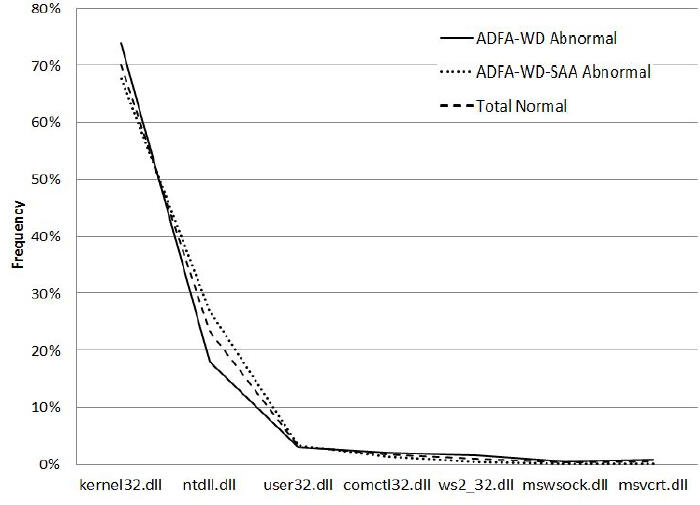
Figure 1. Audit data frequency distribution